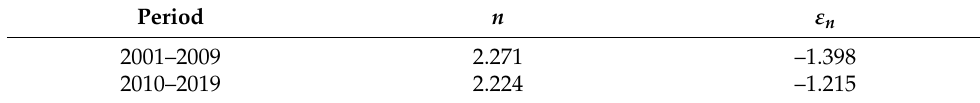
Table 5. The change of parameter n and elasticity during the change period.